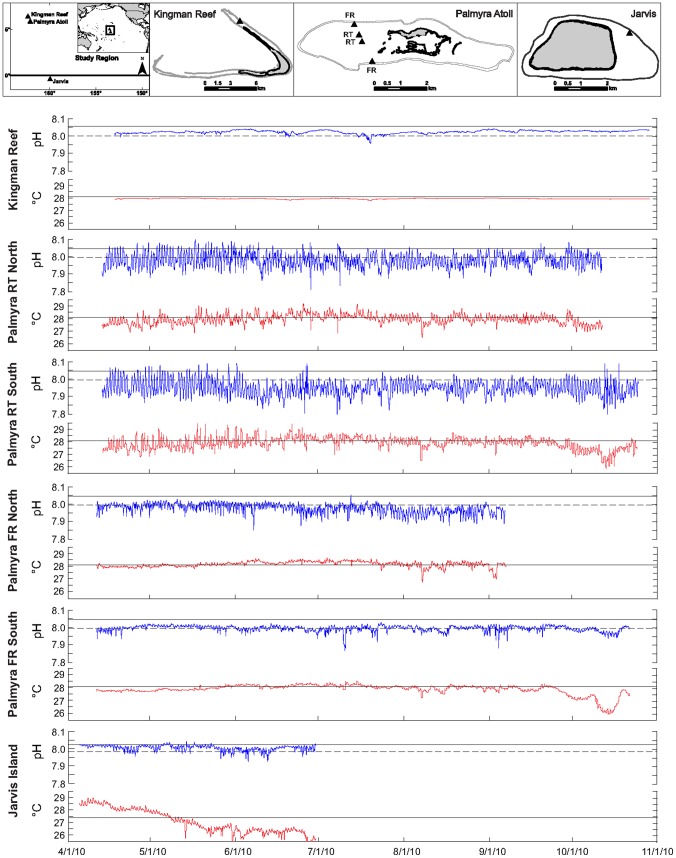
Site locations and continuously logged data (1 hr interval) using the SeaFET sensors.Data are low-pass filtered (period = 2 hrs). The solid black lines in the pH and temperature plots represent a regional climatological mean (e.g. pHcm), generated by combining the World Ocean Atlas 2009 (WOA09) data, the Takahashi pCO2 climatology [28], and the AT climatology of Lee et al. [29]. In the pH plots, the dashed lines are the pHcsl values at the climatological seasonal low. FR = forereef, RT = reef terrace.